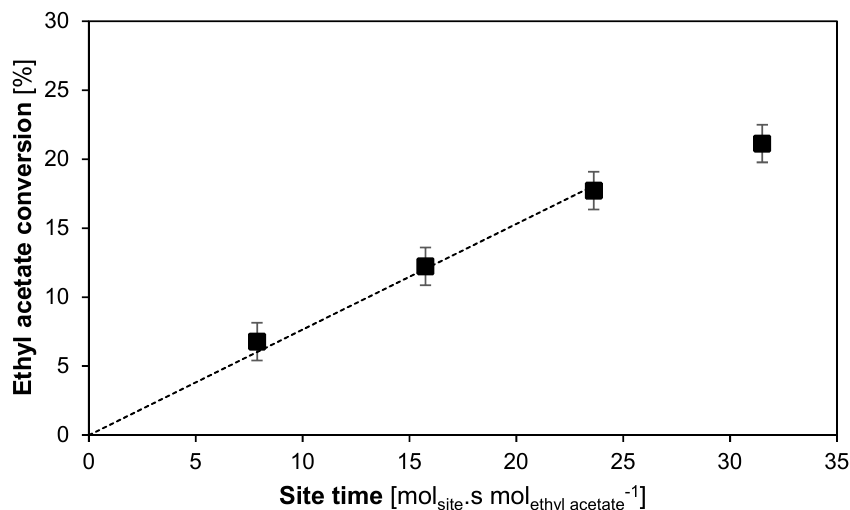
Figure 5. Conversion in function of site time of the Lewatit K2629 for the transesterification between methanol and ethyl acetate. T = 60 °C, P tot = 180 kPa, site time = 7.9–31.5 mol site s mol − 1 , 19.8 wt % ethyl acetate, 71.4 wt % methanol, 8.8 wt % octane (internal standard). Fixed error of 1.4%.